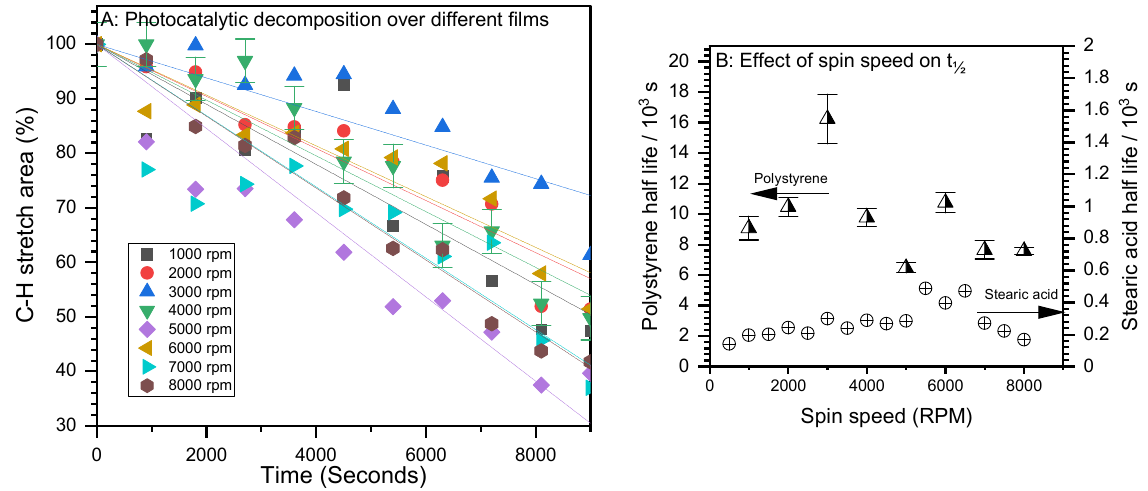
Figure 2. ( A ). Comparison of photocatalytic decomposition rates of polystyrene over Cu/TiO 2 films prepared at different spin rates. Error bars have only been included for one data set for clarity, but a typical error calculated from repetition is ±4%. ( B ): Calculated t ½ lives of polystyrene vs. spin speed compared with the t ½ lives of stearic acid deposited on the equivalent films.